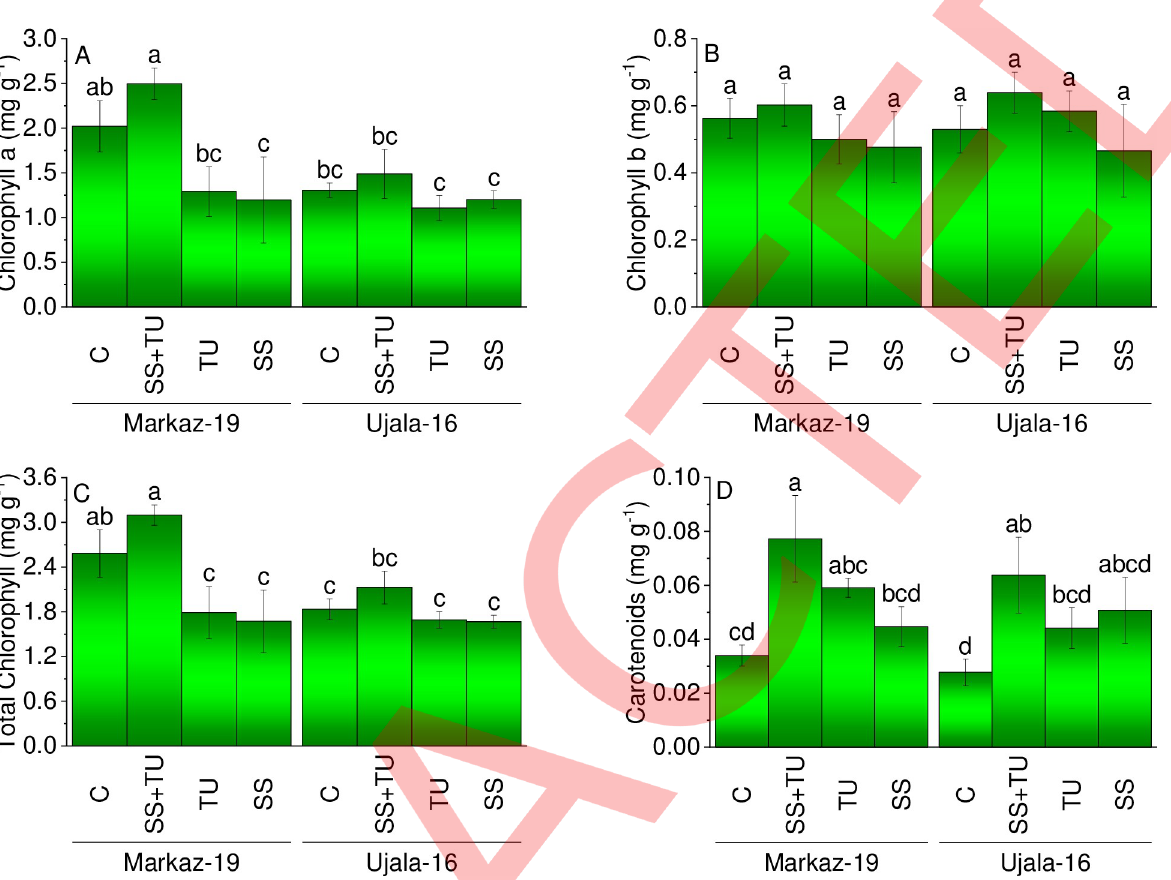
Fig 2. Effect of different treatments on chlorophyll a (A), chlorophyll b (B), total chlorophyll (C) and carotenoids (D) of two wheat genotypes (Markaz 19 and Ujala 16) after 35 d of growth in pots. All values are the mean of 4 replicates. Error bars are showing ± standard error. Different letters on bars are significantly different at p < 0.05 according to LSD test. C: Control, SS+TU: sewage sludge+thiourea, TU: thiourea, SS: sewage sludge.